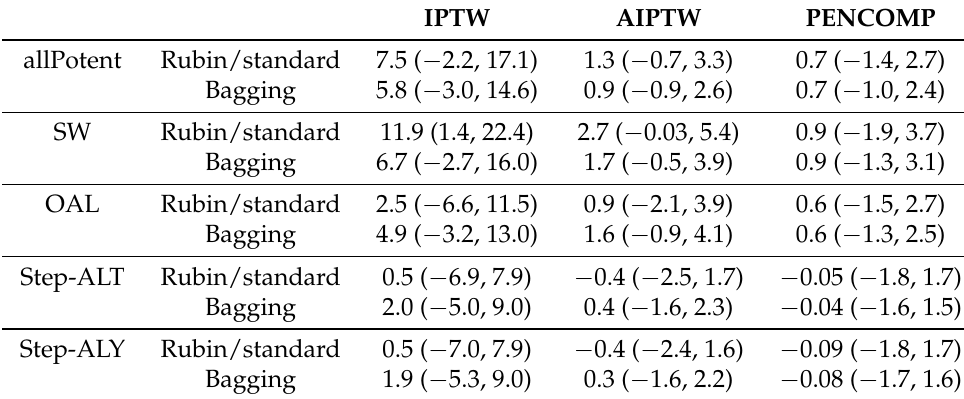
Table 5. Treatment effect estimates and 95% confidence